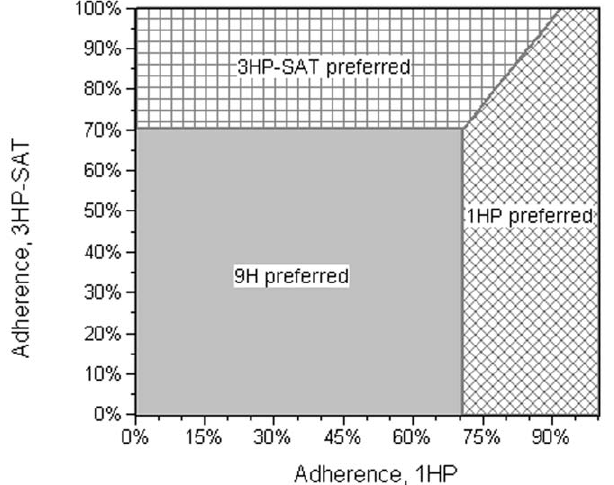
Figure 3. Two-way sensitivity analysis strategy graph compar- ing adherence for isoniazid/rifapentine daily for one month (1HP) vs. isoniazid/rifapentine weekly for three months self- administered (3HP-SAT). In the diagonal cross-hatched area, 1HP is cost-saving and therefore the preferred regimen. In the horizontal cross-hatched area, 3HP-SAT is cost-saving. In the shaded area, neither regimen is cost-saving when compared to isoniazid monotherapy daily for nine months (9H), which is the preferred regimen.